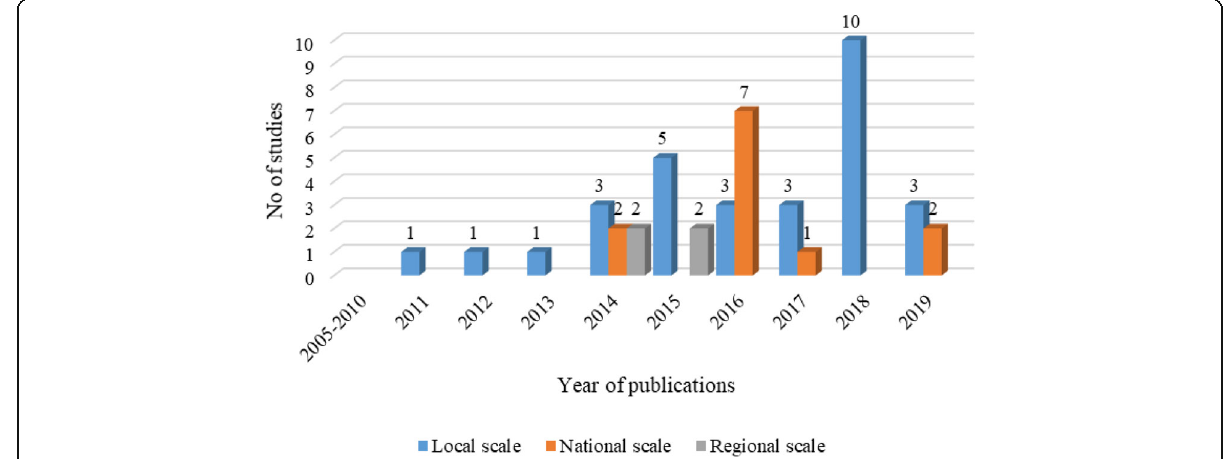
Fig. 5 The number of studies of the selected literature based on study scale and year of